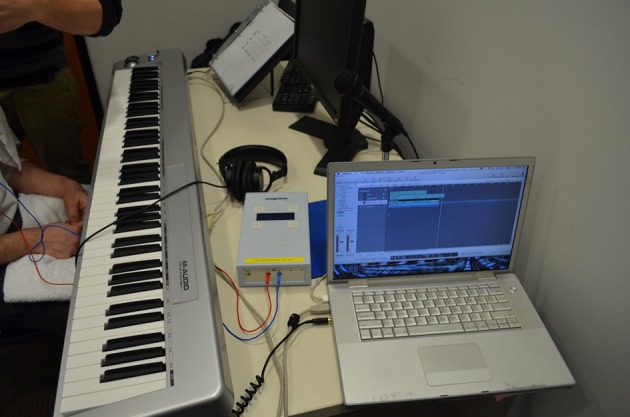
Experimental setup.